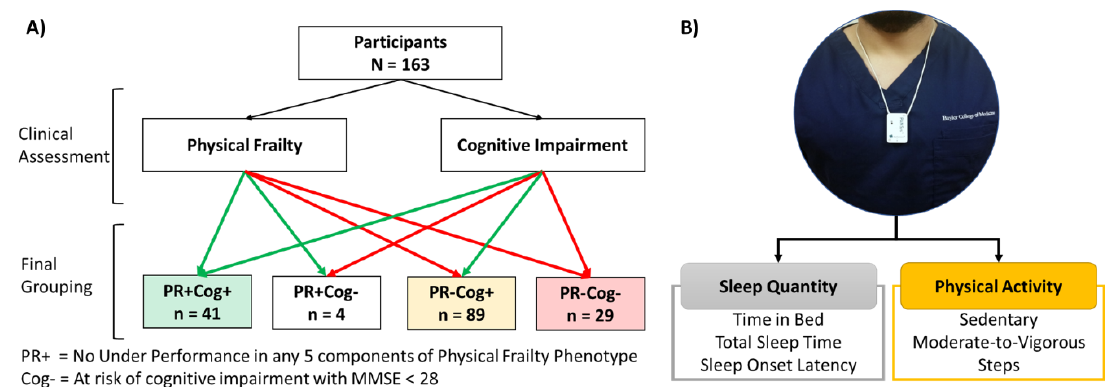
Figure 1. ( A ) CONSORT diagram of participants recruitment. ( B ) Placement of sensor and the samples of variables extracted from a single sensor.